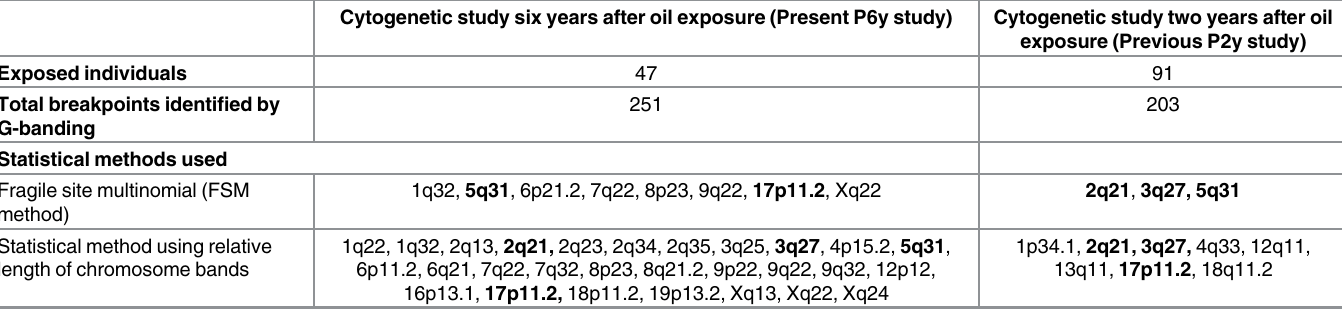
Table 2. Chromosome bands most affected by spontaneous breakage only in exposed individuals two and six years after oil spill exposure.